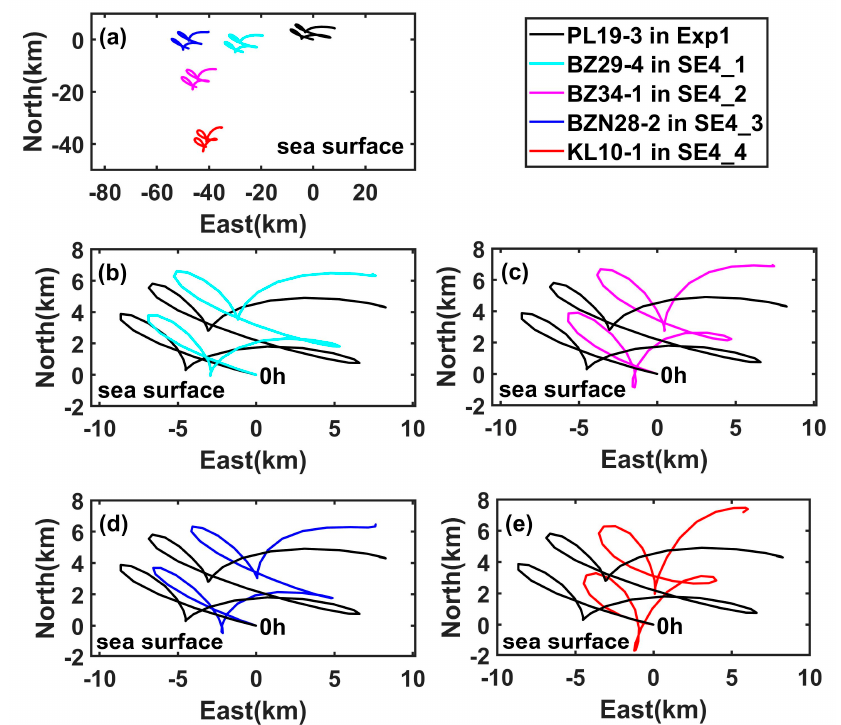
Figure 14. ( a ) Simulated centroid trajectory at the sea surface (relative to the position of PL19-3) in Exp1 (black line), SE4_1 (cyan line), SE4_2 (magenta line), SE4_3 (blue line), and SE4_4 (red line); ( b ) Comparison between the simulated centroid trajectory (relative to its own platform position) at the sea surface in Exp1 (black line) and that in SE4_1 (cyan line); ( c – e ) are similar to ( b ), but for SE4_2, SE4_3, and SE4_4.